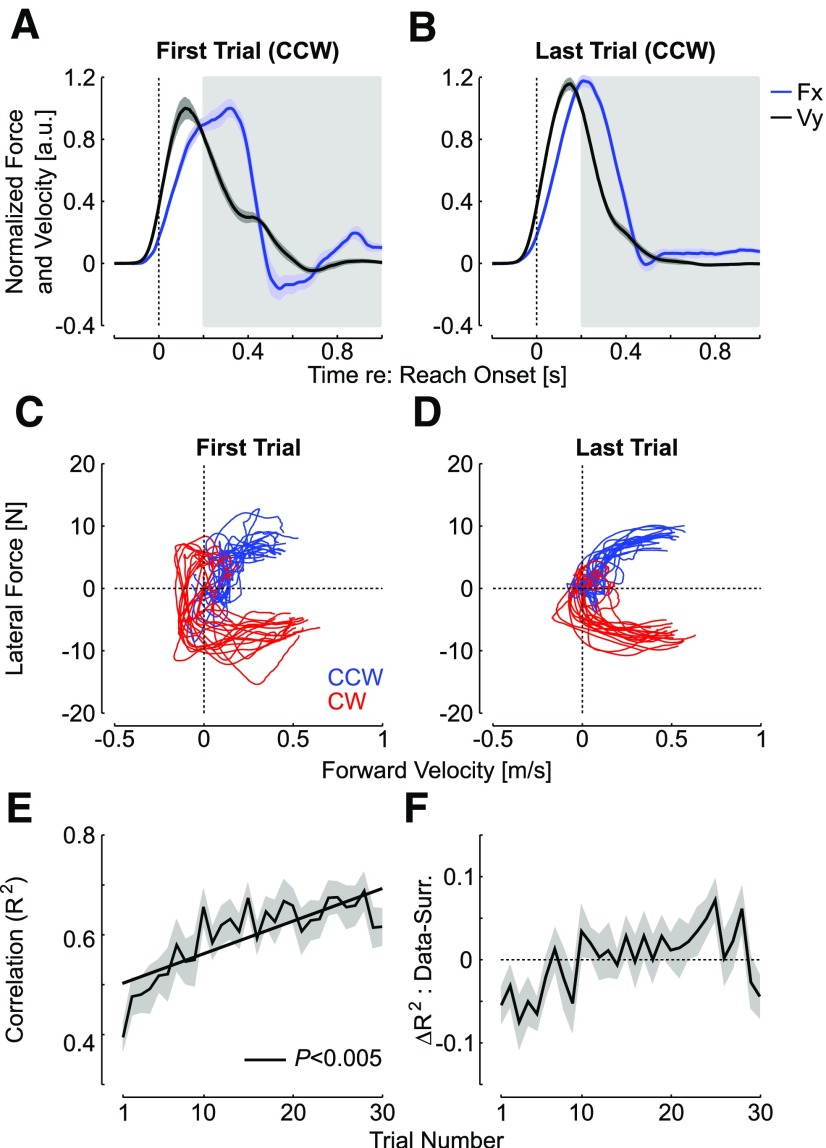

A, Forward hand velocity (black) and measured lateral force (blue) normalized to the average maximum calculated on the first trial. Shaded areas represent one standard error across participants (n = 18). Panels display data from the trials with counterclockwise force field perturbation. B, Same as panel a for the last trial normalized to the average maximum of the first trial. C, Lateral force as a function of the forward velocity for CW and CCW perturbations (red and blue, respectively). D, Same as C for the last trial. For panels C, D, there was one trace per participant. Observe that the traces were smoother in the last trials. E, Mean ± SEM of the linear correlation (R2 statistics) across force field trials from experiment 1 (CCW and CW perturbations averaged). F, Difference between the correlations from experiment 1 as calculated in C, and the correlation between the lateral force of each trial with the forward hand velocity of a randomly picked surrogate trial with replacement. The surrogate correlations were calculated 100 times per trial and participants and averaged across. The shaded area is one SEM.